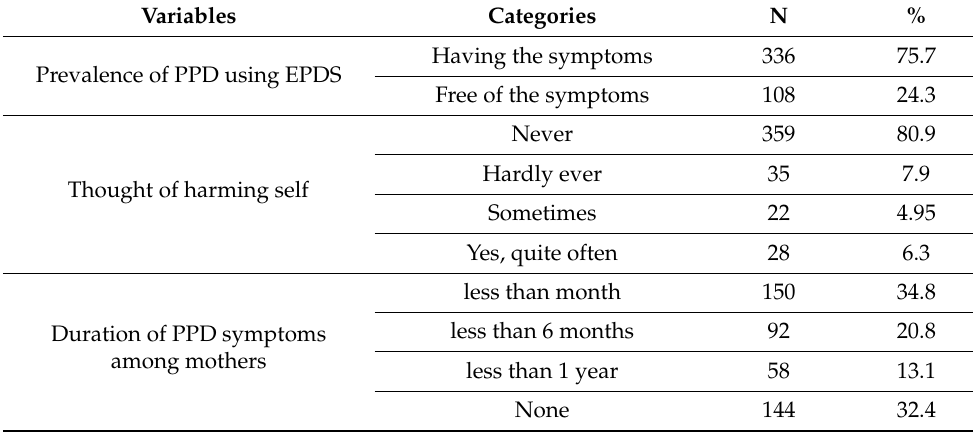
Table 2. Prevalence, pattern and health care seeking behavior regarding